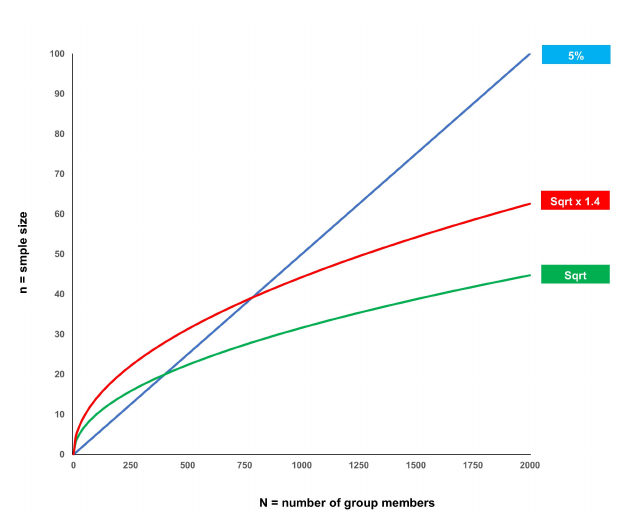
Figure 2. Sample size for group inspection, using n = 0 . 05 N compared to n =